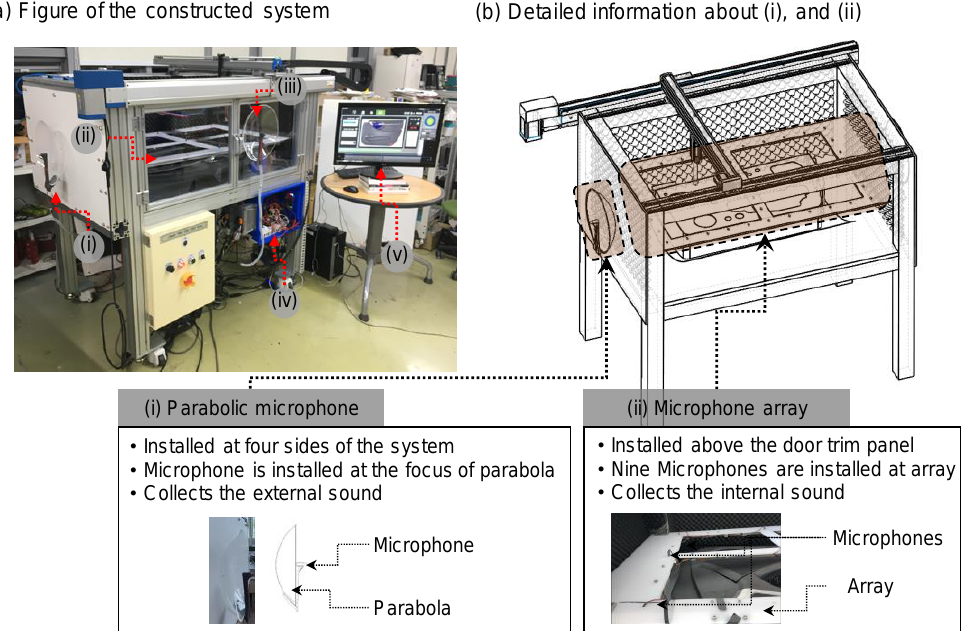
Figure 3. Configuration of the in-process BSR noise detection system: ( a ) image of the constructed system consisting of (i) four parabolic microphones, (ii) a sensor array of nine microphones, (iii) a pneumatic pusher controlled by a gantry robot, (iv) a data acquisition system, and (v) noise detection